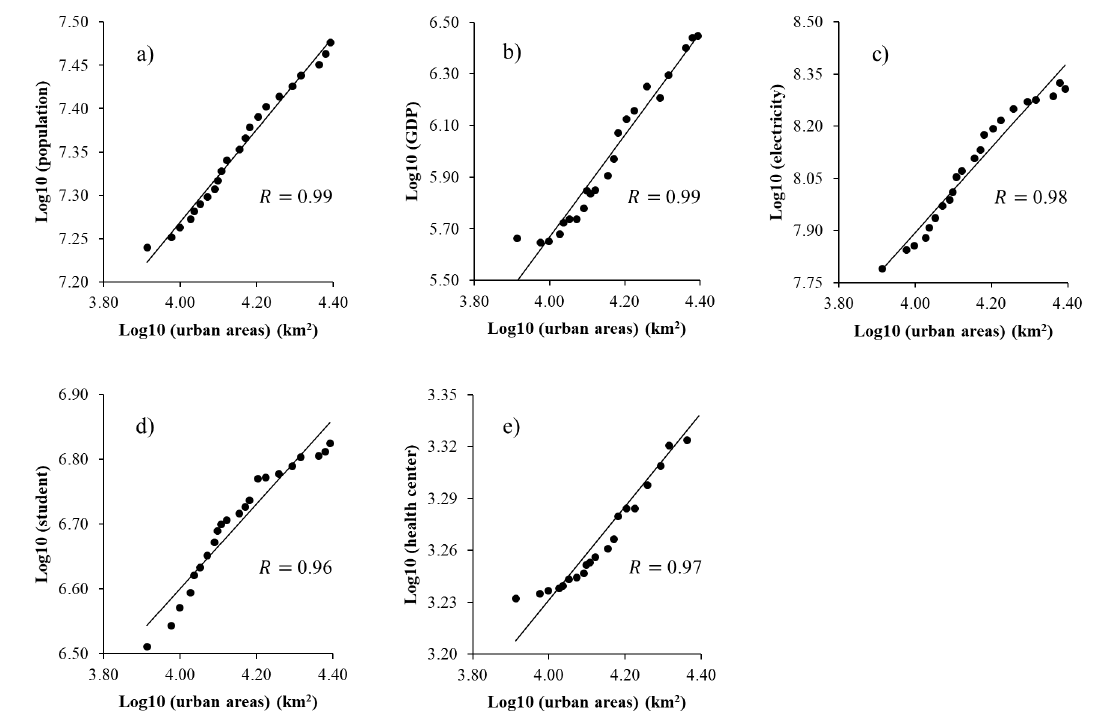
Figure 8. Total urban area (km 2 ) in Saudi Arabia from 1992 to 2013.